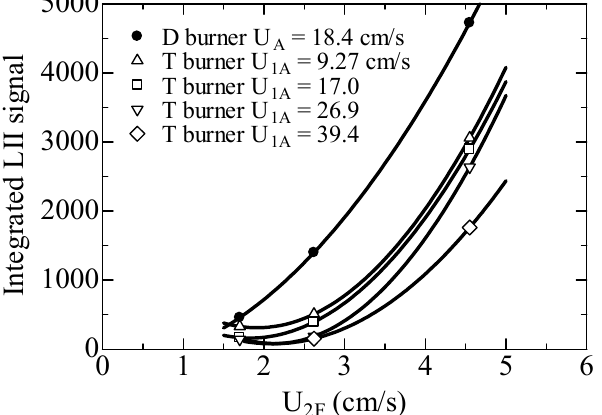
Figure 8. Integrated LII signal for total soot amount at different fuel flow